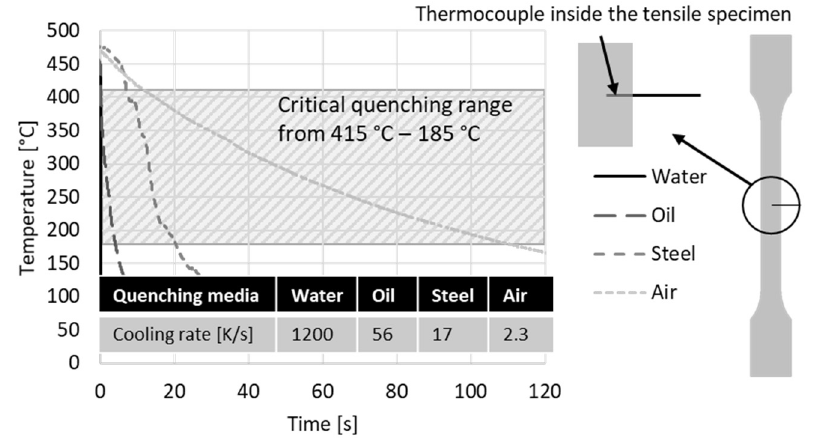
Figure 9. Cooling rates of different quenching media.